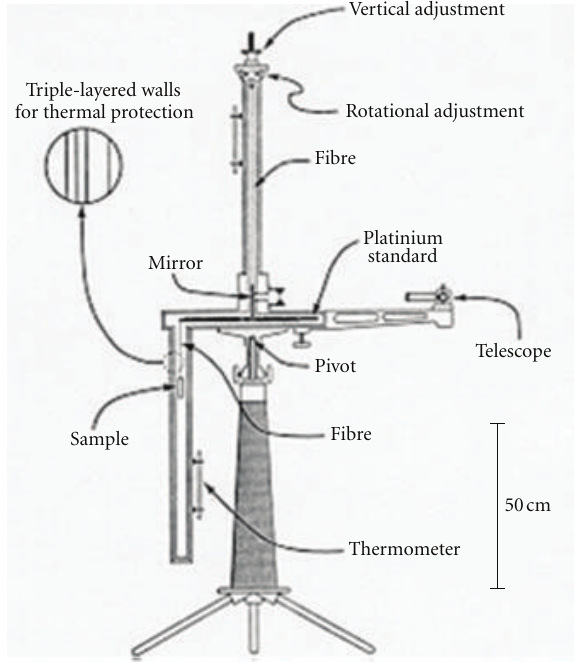
Figure 2: Eotvos Torsion